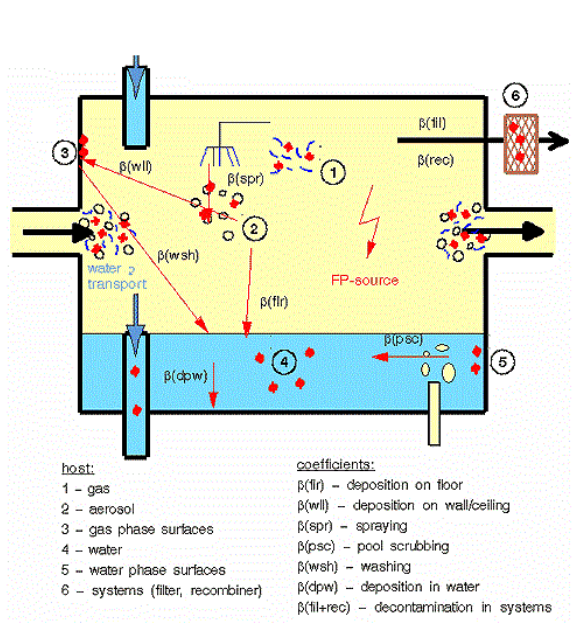
Figure 1. Scheme of iodine chemistry in NPP con- tainment